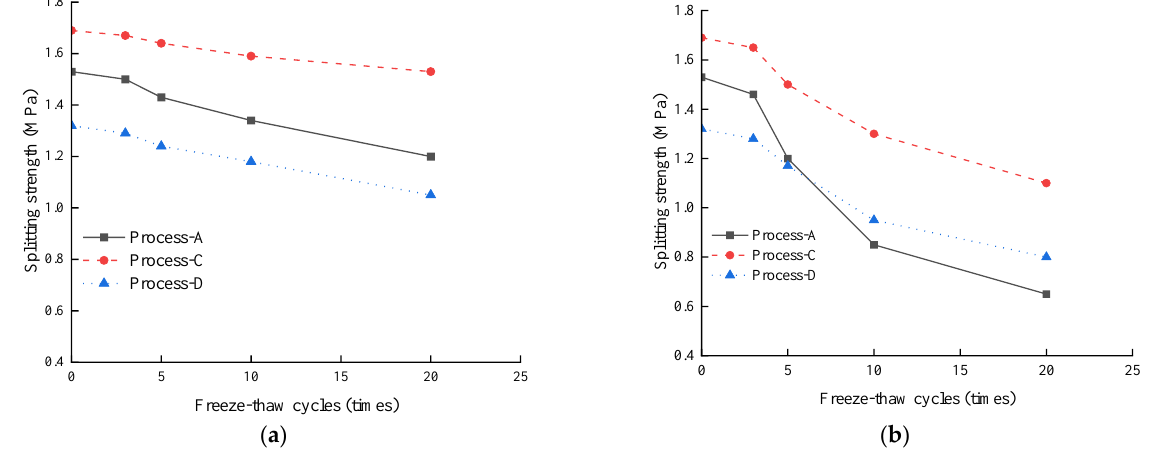
Figure 12. Relationship between splitting strength and freeze–thaw cycles: ( a ) completely dry condition; ( b ) water saturation condition.